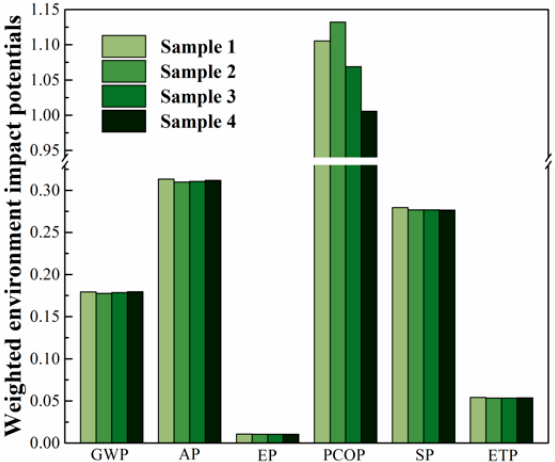
Figure 4. Weighted environmental impact potentials for the PLA-based WPCs during the cradle-to-gate stages.